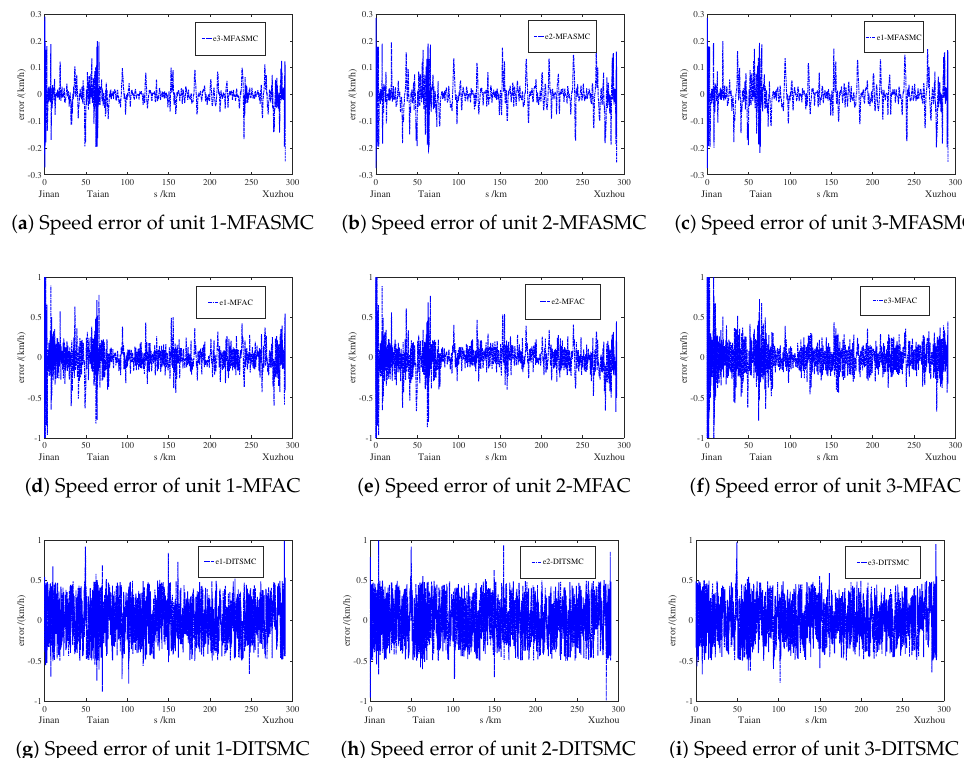
Figure 11. Speed tracking error curves of each power unit for the three